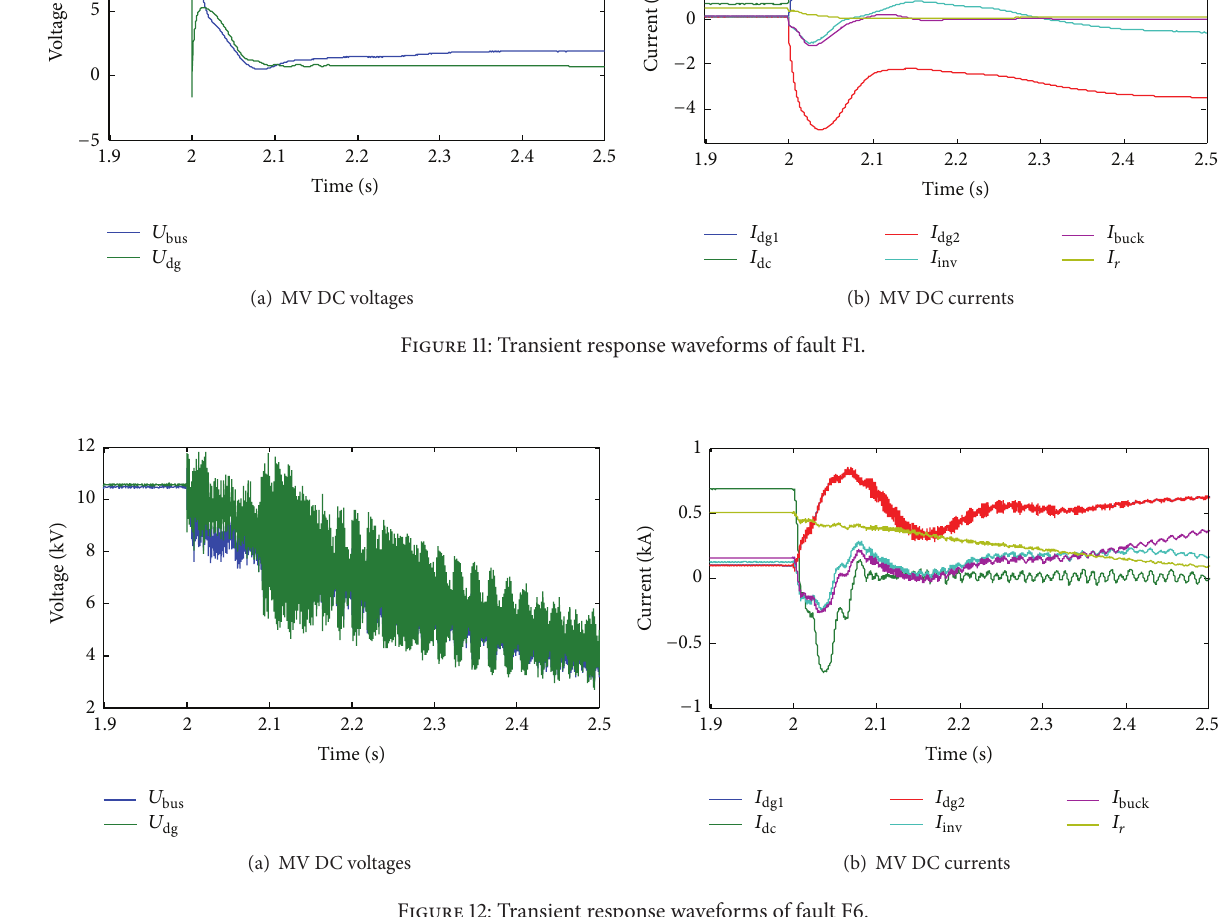
Figure 12: Transient response waveforms of fault F6.